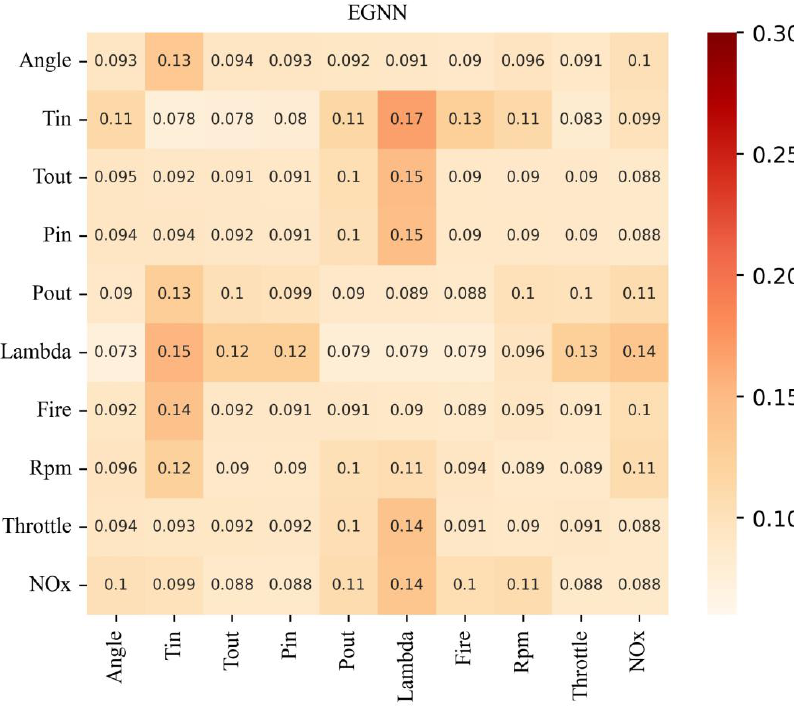
Figure 11. Graph attention result of EGNN. The data in every grid represent the attention score of the variable to another variable.